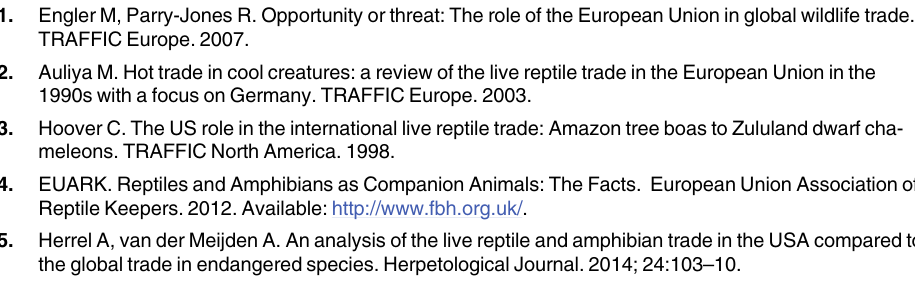
S1 Table. Respondents ’ evaluation of Additive RRT. Evaluation of additive RRT, including percentage responses for each category. Questions were asked according to a five point Likert scale, with categories condensed for data